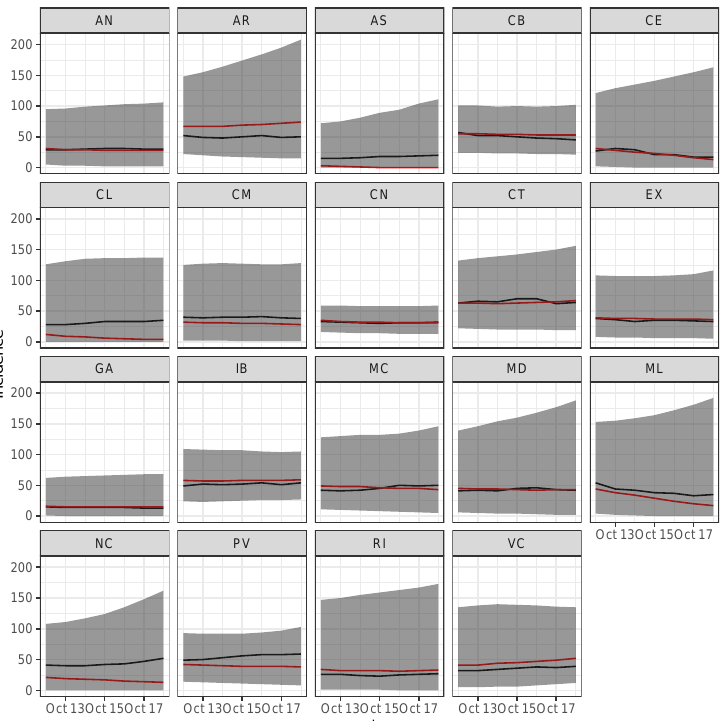
Figure A5. Predicted incidence (cid:98) y ts (red) with their 99% CI (shaded grey area) and observed daily incidence (black) over last observed week (12th till 18th October) when these observations have been never used to train the model, such that the first day is one day ahead prediction and last is 7 days ahead prediction. Table A1. Predicted incidence (cid:98) y ts with their 99% CI and observed daily incidence over last observed week (12th till October 18th). These observations are out of the training sample. The first day is one day ahead prediction, and the last is seven days ahead prediction. These numbers appear in Figure A5. Number of Days Ahead Predictions Region